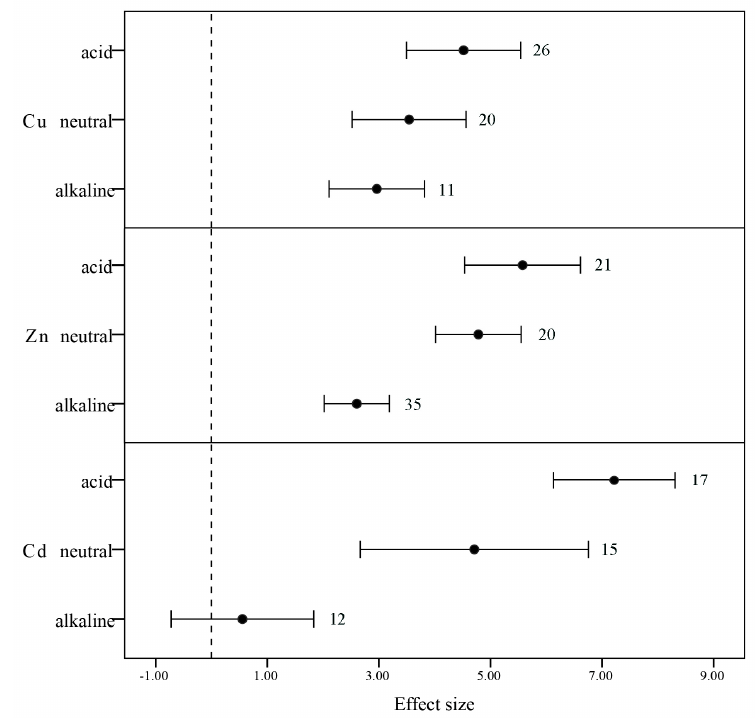
Figure 4. The mean BCFs values of heavy metals Zn, Cu, and Zn concentration on aquatic plant categorized by pH: acidic (5.5–6.5), neutral (6.5–7.5), and alkaline (7.5–8.5). Error bars represent 95% bootstrapped confidence intervals (CIs). The effect of heavy metal concentration ability in aquatic plants was considered significant if the 95% CI of the effect size did not overlap with zero. The number of observations for each category is shown next to the error bars.